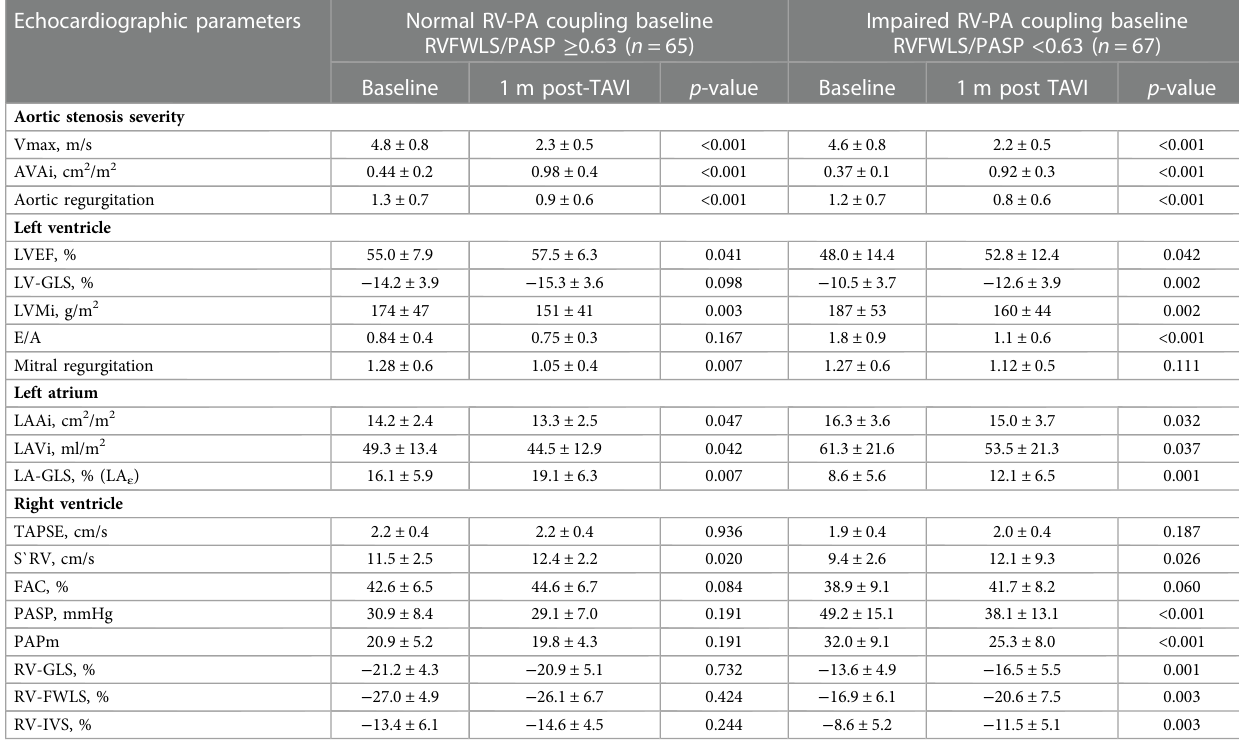
TABLE 4 Echocardiographic changes after TAVI according to baseline RV-PA coupling impairment (short-term effect of TAVI on RV-PA coupling). Echocardiographic